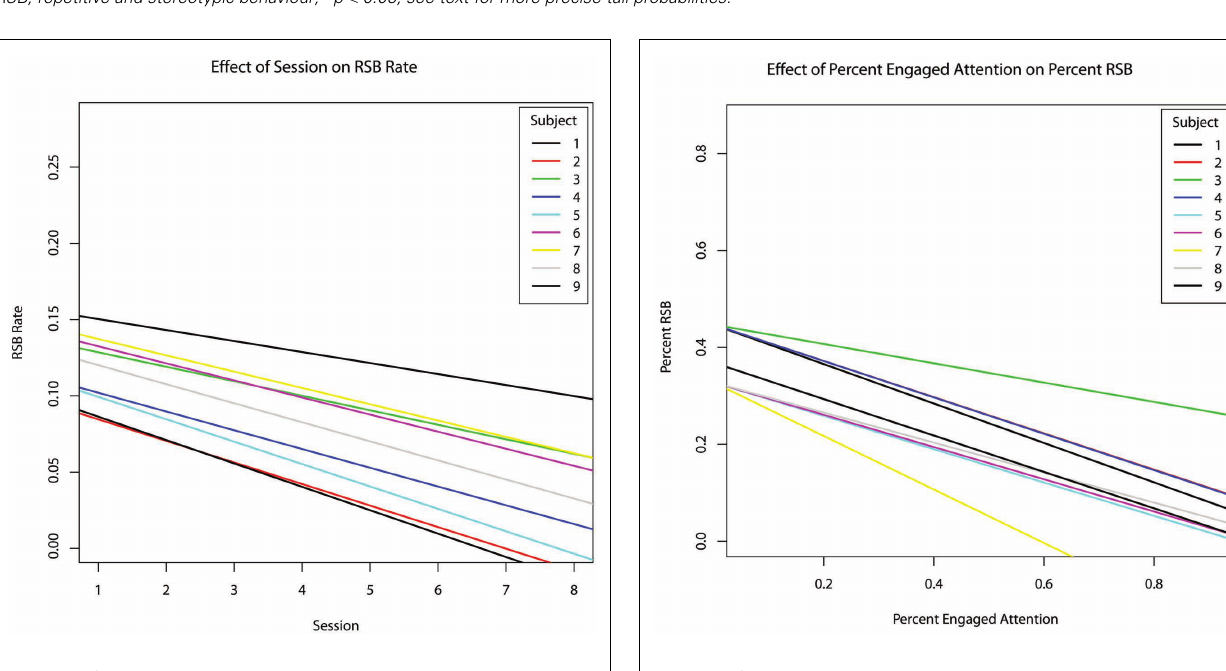
FIGURE 1 |The effect of chronological session number on the incidence rate of repetitive and stereotypic behaviours per second, controlling for age.